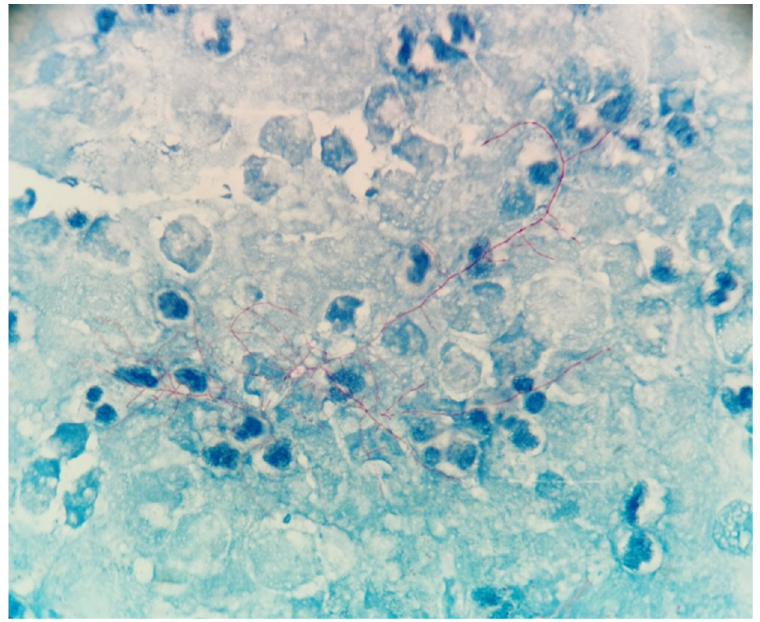
Figure 1. Partial acid fastness of the bacteria was demonstrated using modified Kinyoun’s procedure (×1000).